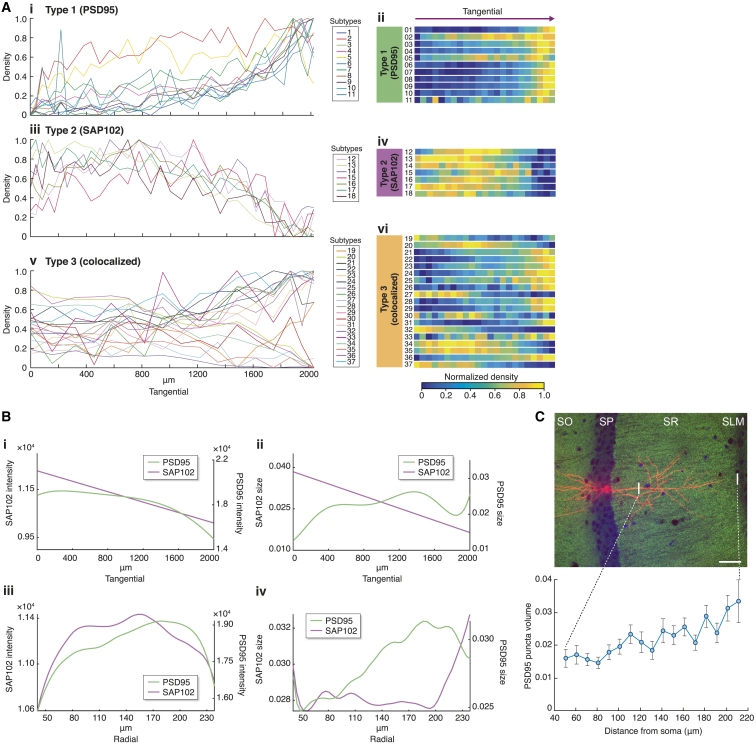
Synapse Gradients in the Hippocampal Formation(A) Line plots (i, iii, and v) and heatmaps (ii, iv, and vi) of the normalized density for type 1 (PSD95-only) (i and ii), type 2 (SAP102-only) (iii and iv) and type 3 (colocalized) (v and vi) subtypes on CA1sr tangential axis. Density unit, A.U.(B) Tangential and radial gradients of PSD95 and SAP102 punctum intensity (I and iii) and size (ii and iv) in CA1sr. Intensity, 16-bit grayscale; size, μm3.(C) Top: Alexa-594-injected pyramidal neuron (red) in the CA1 and PSD95 punctum labeling (green). DAPI staining, blue. Scale bar, 35 μm. SLM, stratum lacunosum-moleculare. SO, stratum oriens; SP, stratum pyramidale; SR, stratum radiatum; Bottom: PSD95 punctum volume (μm3) as a function of distance from the soma in apical dendrites of dye-filled CA1 pyramidal neurons (mean ± SEM). Dotted lines indicates range of plotted data.